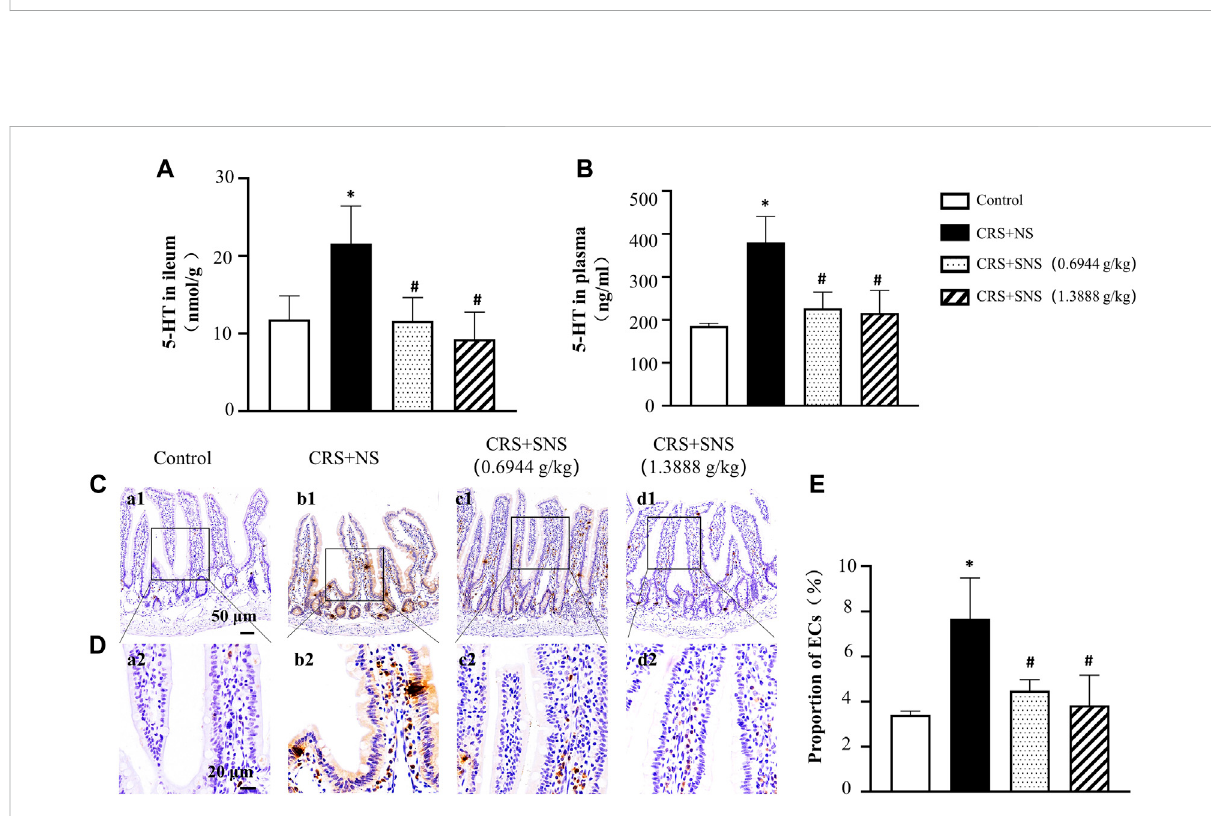
FIGURE 10 Effect of the SNS treatment on 5-HT content in the ileum tissue and plasma and on the number of ECs of the ileum. (A) 5-HT concentration in ileum tissues from different groups. F = 5.845. p = 0.0106. (B) 5-HT concentration in the plasma from different groups. F = 15.30. p = 0.0002. (C) Representative low magni fi cation of immunehistochemical staining images of anti-5-HT antibody in the ileum tissues in Control (a1), CRS + NS (b1), CRS + SNS (0.6944 g/kg) (c1), CRS + SNS (1.3888 g/kg) (d1) groups, respectively. Bar = 50 μ m. (D) Representative high magni fi cation of immunohistochemicalstainingimagesoftheanti-5-HTantibodyintheileumtissuesintheControl(a2),CRS+NS(b2),CRS+SNS(0.6944 g/kg)(c2), CRS + SNS (1.3888 g/kg) (d2) groups, respectively. Bar = 20 μ m. (E) The counts of ECs in the ileum tissue of the rats in each group. F = 8.487. p = 0072. Results are presented as mean ± SEM.* p < 0.05 vs. Control group; # p < 0.05 vs. CRS + NS group. (A,B) n = 4. (C – E) n =